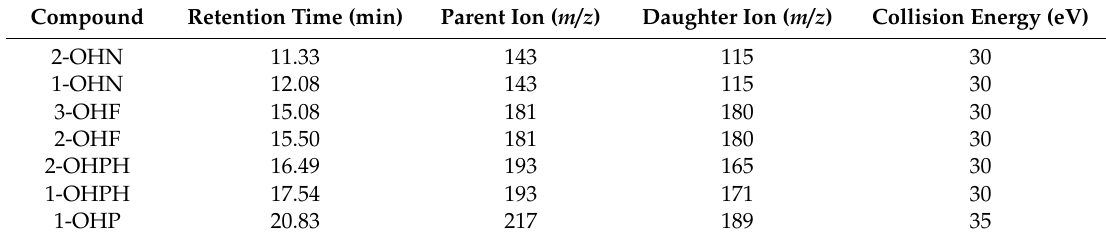
Table 1. The spectrometry measurement parameters of seven hydroxylated metabolites of polycyclic aromatic hydrocarbons